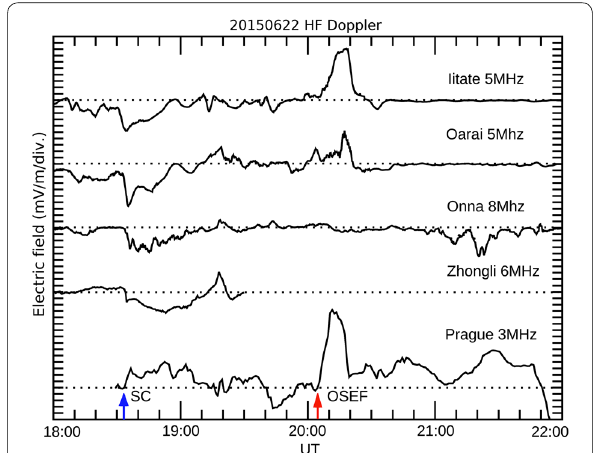
Fig. 4 Electric fields observed with the HF Doppler sounders in the western Pacific zone; Iitate, Oarai, Onna, Japan, and Zhongli, Republic of China, in the post-midnight (03–06 MLT) and in the Europe zone; Prague, Czech Republic in the evening (19–22 MLT). The electric field is positive/eastward. OSEF refers to the overshielding electric